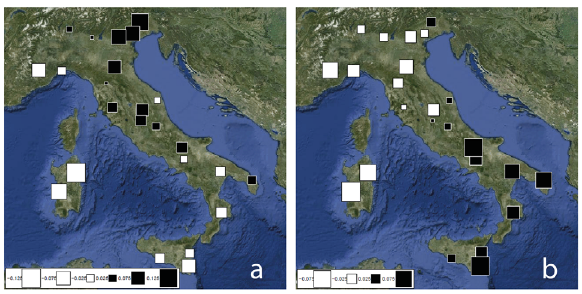
Figure 3. Spatial Principal Component Analysis (sPCA) based on frequencies of mtDNA haplogroups. The first two global components sPC1 (a) and sPC2 (b) are depicted. Positive values are represented by black squares; negative values are represented by white squares; the size of the square is proportional to the absolute value of sPC